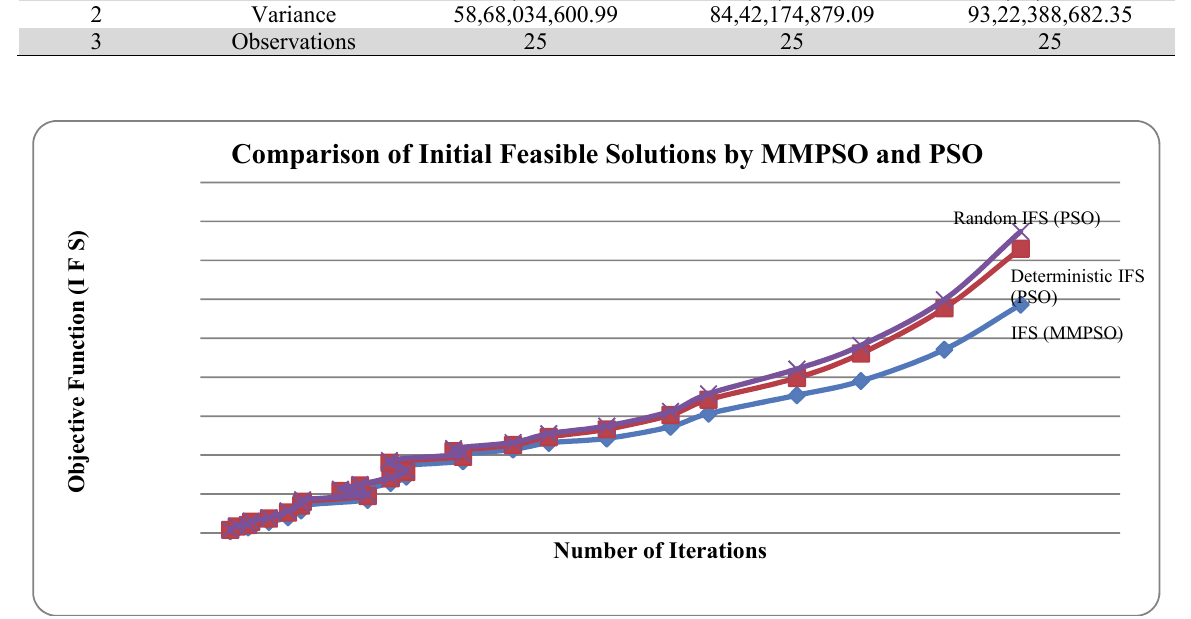
Fig. 7. Comparison of Initial Feasible Solutions by MMPSO and PSO